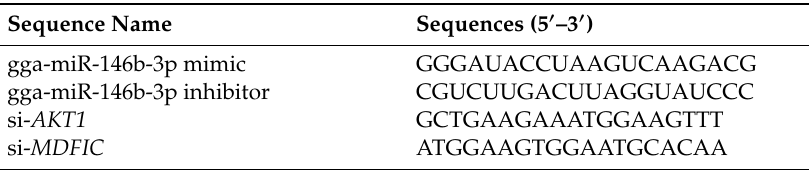
Table 2. Oligonucleotide sequences used in this study.